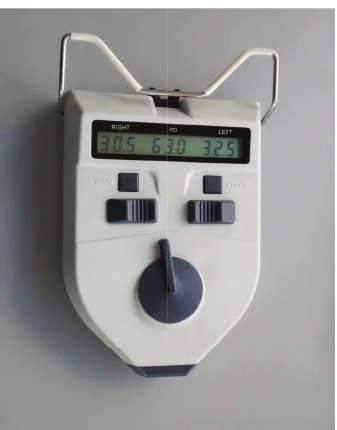
Figure 1: Digital pupillometer that shows in the center the ID and to the sides the NPD of each eye.